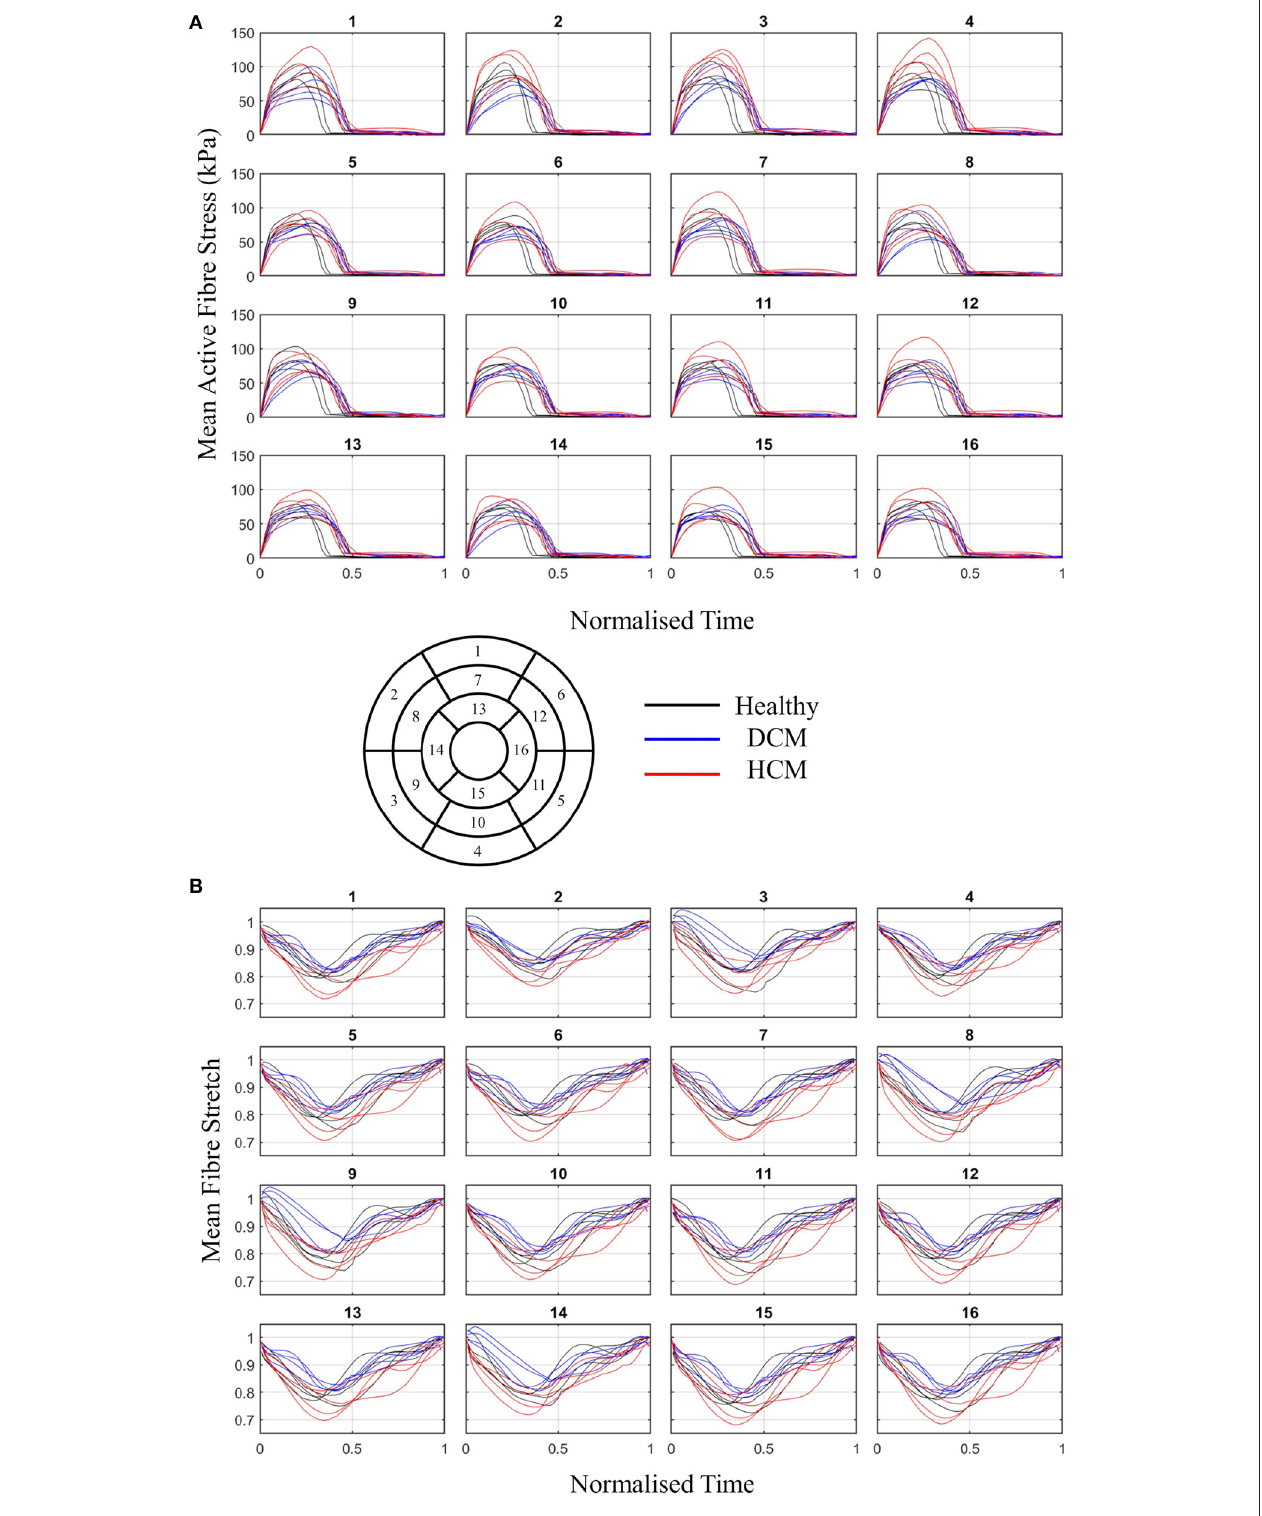
FIGURE 9 | (A) Mean active fibre stress and (B) fibre stretch over the cardiac cycle in 16 AHA regions of the LV for healthy (black), DCM (blue), and HCM (red) groups.